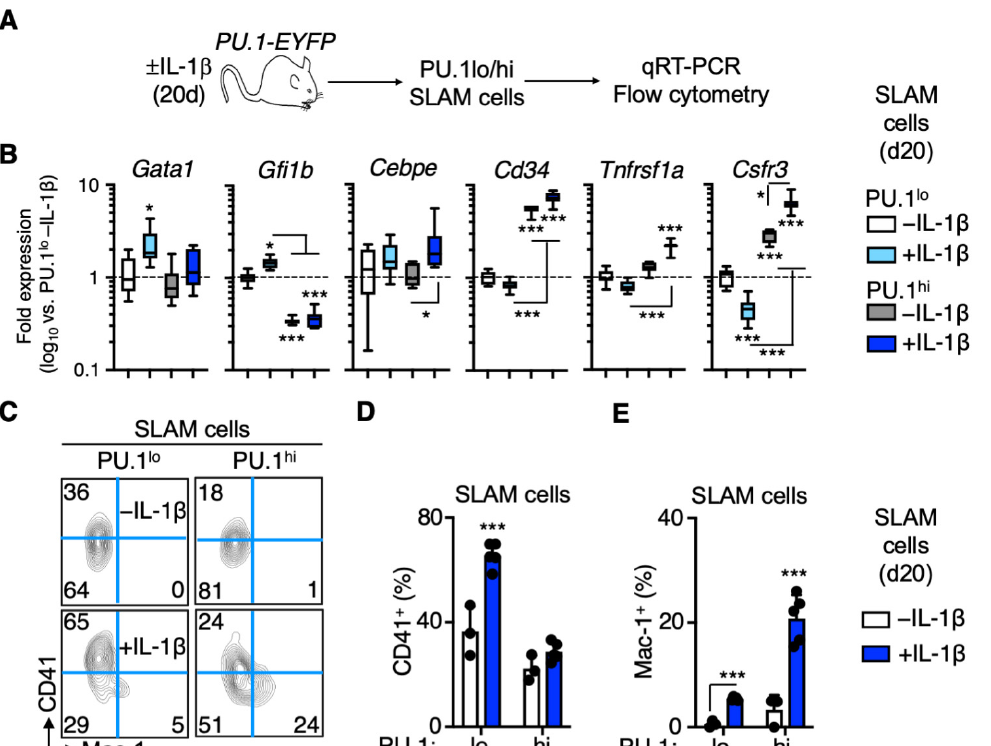
Figure 3. Distinct patterns of lineage priming in the SLAM compartment associated with PU.1 lev- els. ( A ) Experimental design for analysis of SLAM cells from PU.1-EYFP mice treated for 20 d IL-1 β . ( B ) Fluidigm qRT-PCR analysis of megakaryocyte/erythroid and myeloid lineage genes in PU.1 lo and PU.1 hi SLAM cells from PU.1-EYFP mice treated for 20 d IL-1 β ( n = 8/grp). Data are expressed as log10 fold change versus PU.1 lo -IL-1 β . Box represents upper and lower quartiles, with line rep- resenting median value. Whiskers represent minimum and maximum values. Data are representa- tive of two independent experiments. ( C ) Representative FACS plot showing frequencies of CD41 + and Mac-1 + cells within the SLAM gate in PU.1-EYFP mice treated for 20 d IL-1 β . ( D ) Frequency of CD41+ cells within the SLAM gate of PU.1-EYFP mice treated for 20 d IL-1 β ( n = 3–5/grp). Individual values are shown, and bars represent mean values. Data are representative of two independent ex- periments. ( E ) Frequency of Mac-1+ cells within the SLAM gate of PU.1-EYFP mice treated for 20 d IL-1 β ( n = 3–5/grp). Individual values are shown, and bars represent mean values. Data are repre- sentative of two independent experiments. Data are shown as means SD. Significance was deter- mined by ANOVA with Tukey’s post-test. * p < 0.05; *** p < 0.001.